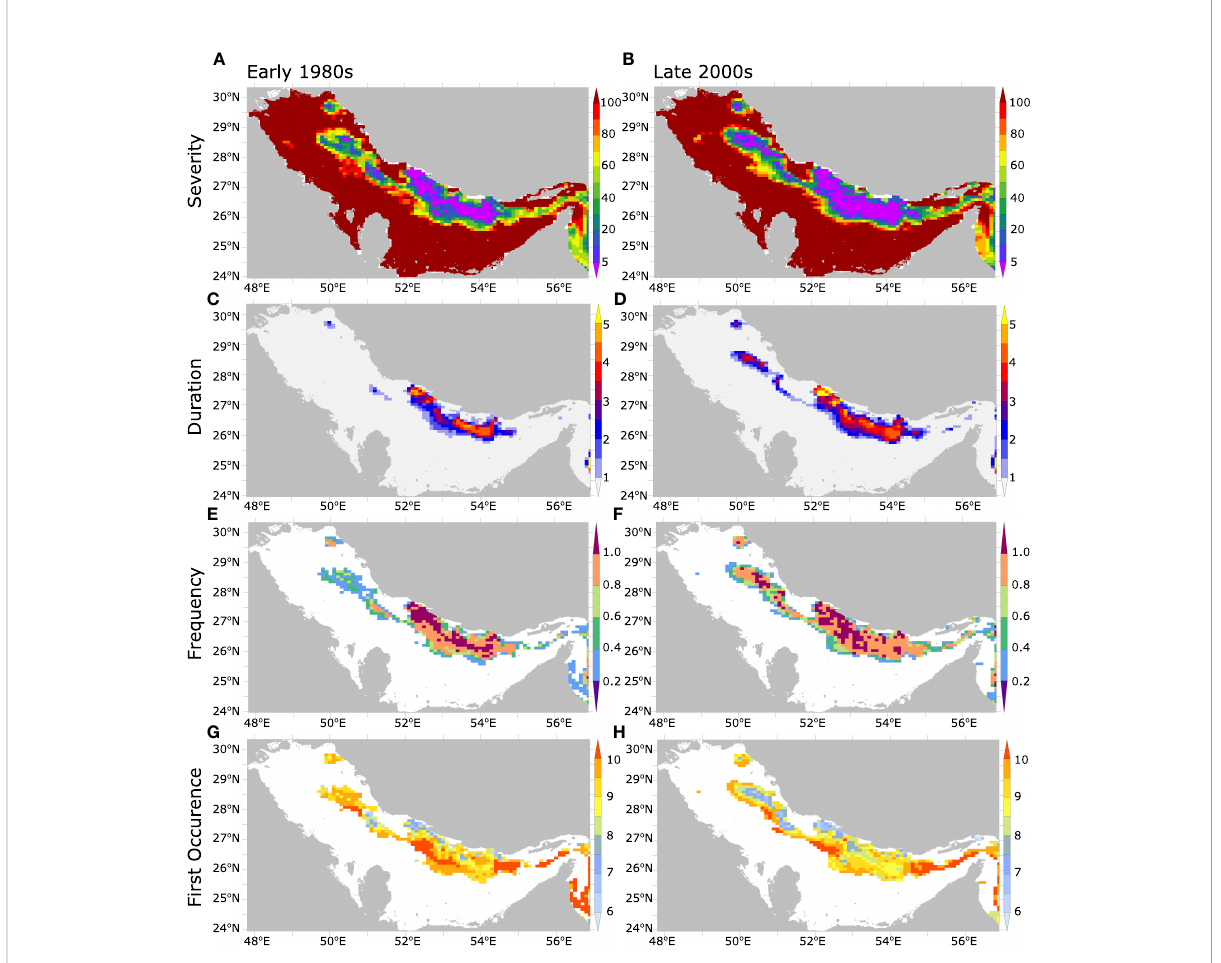
FIGURE 5 Evolution of the statistics of seasonal hypoxia in the Gulf between 1980s and 2000s. Annual near-bottom hypoxia (A, B) severity (i.e., O 2 minimum concentration in mmol m -3 ), (C, D) total duration (in months), (E, F) frequency (number of hypoxic events per year), and (G, H) fi rst occurrence (month of the year) in the early 1980s (1982-1986) (left) and late 2000s (2006-2010)